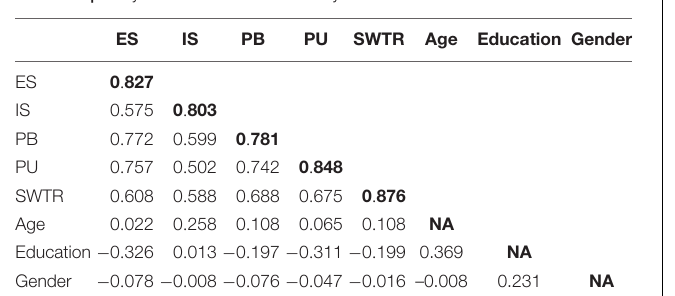
TABLE 4 | Analysis of discriminative validity.